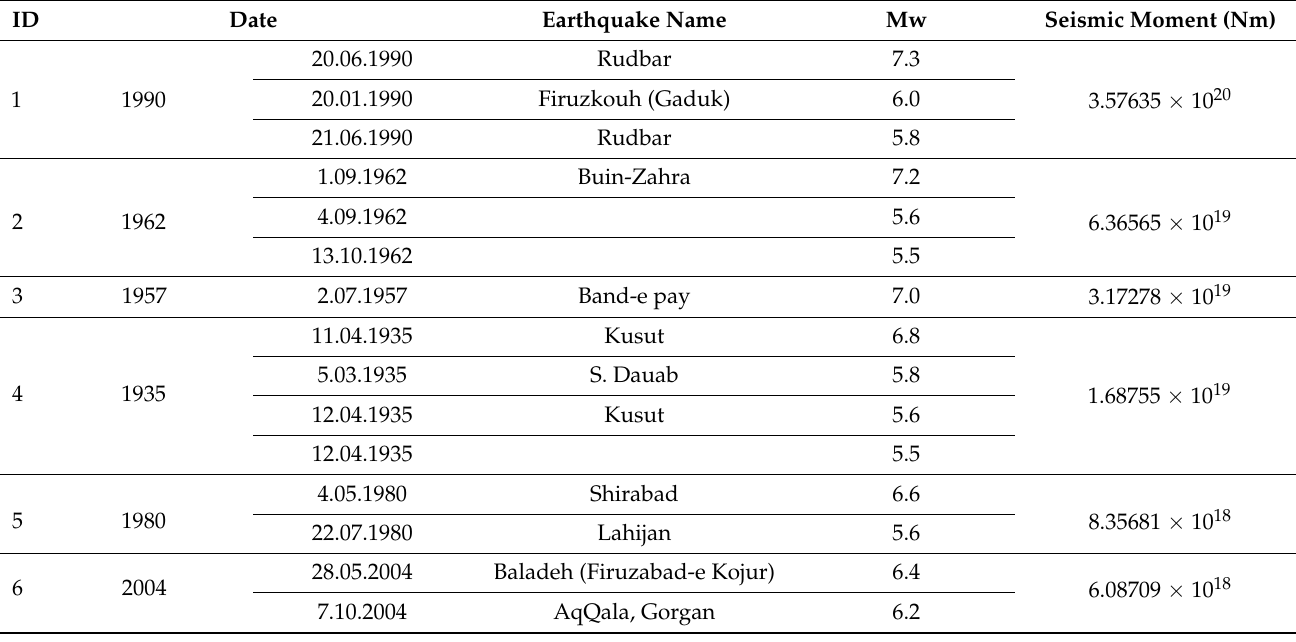
Figure 9. The seismic moment variation for the area during 1900–2020. According to the seismic moment calculations (during the catalog years), the maxi- mum amount of released energy occurred in 1990, 1962, 1957, 1935, 1980, 2004, 2002, and 1953 when the main earthquakes happened (Figure 9, Table 9). Table 9. The destructive earthquakes in the study area with high seismic moment (1900–2020).